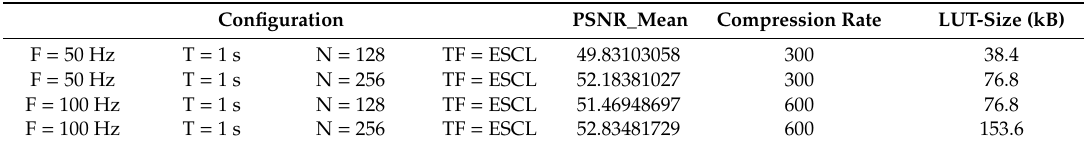
Table 3. Results for the embedded codification. Table 4. Results for generalising the embedded codification.